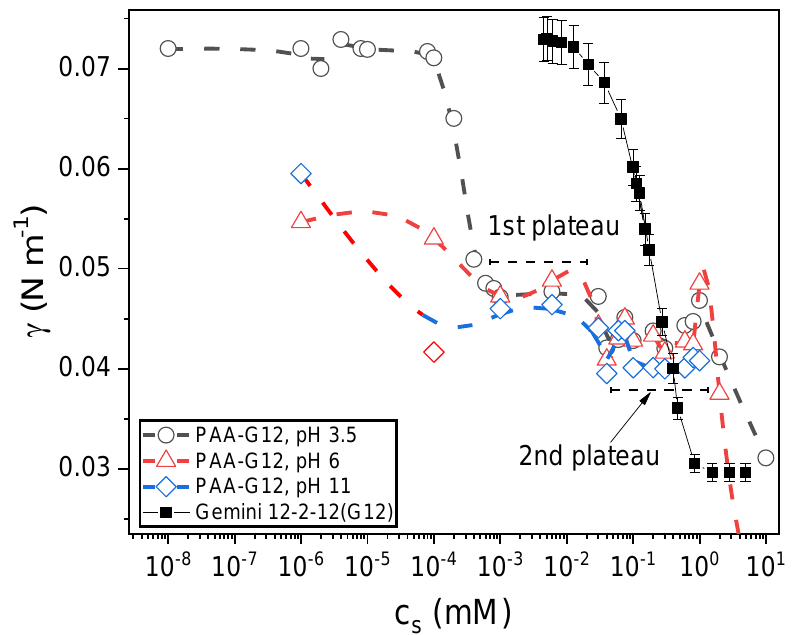
Figure 4. Surface tension isotherms for polyacrylic acid (PAA)-Gemini 12-2-12 (G12) mixtures at different pHs: 3.5 ( open circles ), 6 ( open triangles ), and 11 ( open diamonds ). The surface tension isotherm for PAA-free G12 solutions ( filled squares ) is included.